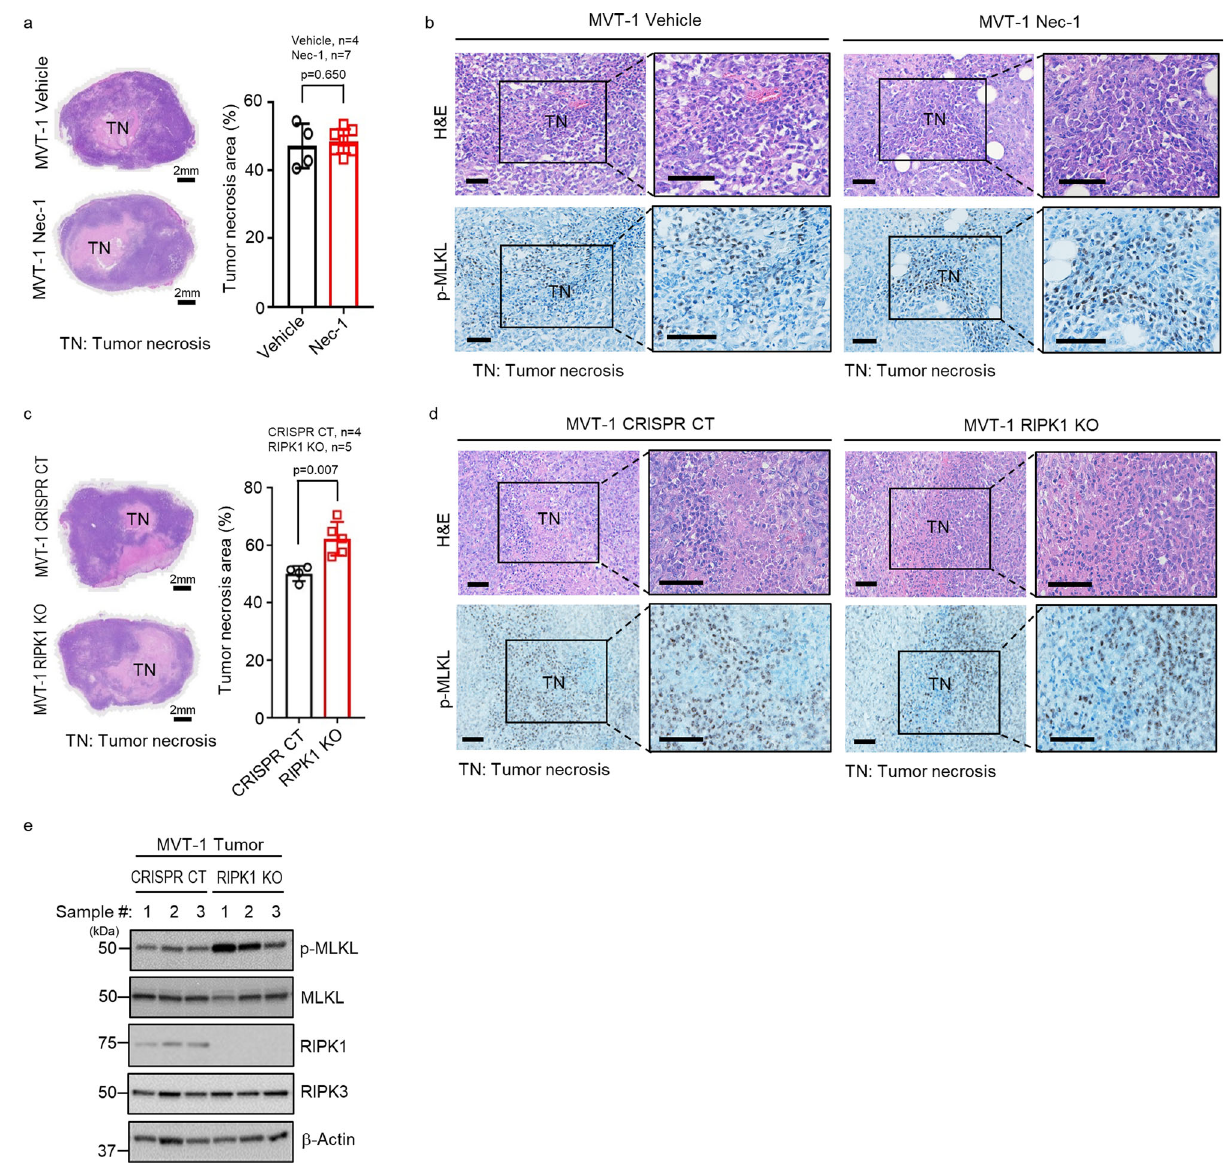
Fig. 1 RIPK1 is not required for MVT-1 mammary tumor necroptosis. a FVB/NJ mice at three weeks post-implantation with MVT-1 cells were treated weekly with vehicle or Necrostatin-1 (Nec-1; i.v .) until week 5. Left panel shows the representative images of H&E stained 5-week tumors of vehicle or Nec- 1 treated mice. Scale bar, 2 mm. Right panel shows the percentage of tumor necrosis area (TN) of the total tumor area from mice at 5-week. Data are presented as mean values± SEM. b Representative H&E and immunohistological images of phospho-MLKL (p-MLKL) antibody staining of tumor sections from mice implanted and treated as in Fig. a . Scale bar, 50 µ m. c MVT-1 CRISPR/Cas9 control (CRISPR CT) or MVT-1 RIPK1 knock out (RIPK1 KO) cells were generated by using the CRISPR/Cas9 system. Left panel shows the representative H&E image of 4-week tumors from FVB/NJ mice implanted with the MVT-1 CRISPR CT or MVT-1 RIPK1 KO cells. Scale bar, 2 mm. Right panel shows the percentage of tumor necrosis area (TN) of the total tumor area after 4-weeks. Data are presented as mean values ± SEM. d Representative H&E and immunohistological images of p-MLKL antibody staining of 4-week tumor sections from mice implanted as in Fig. c . Scale bar, 50 µ m. e Western blotting analysis of tumor lysates from mice implanted as in Fig. c using the indicated antibodies. Western blotting analysis representative of three independent experiments. Two-sided student ’ s t test was used to determine the statistical signi fi cance of differences between groups. Differences with P values < 0.05 were considered signi fi cant. Source data are provided as a Source Data fi